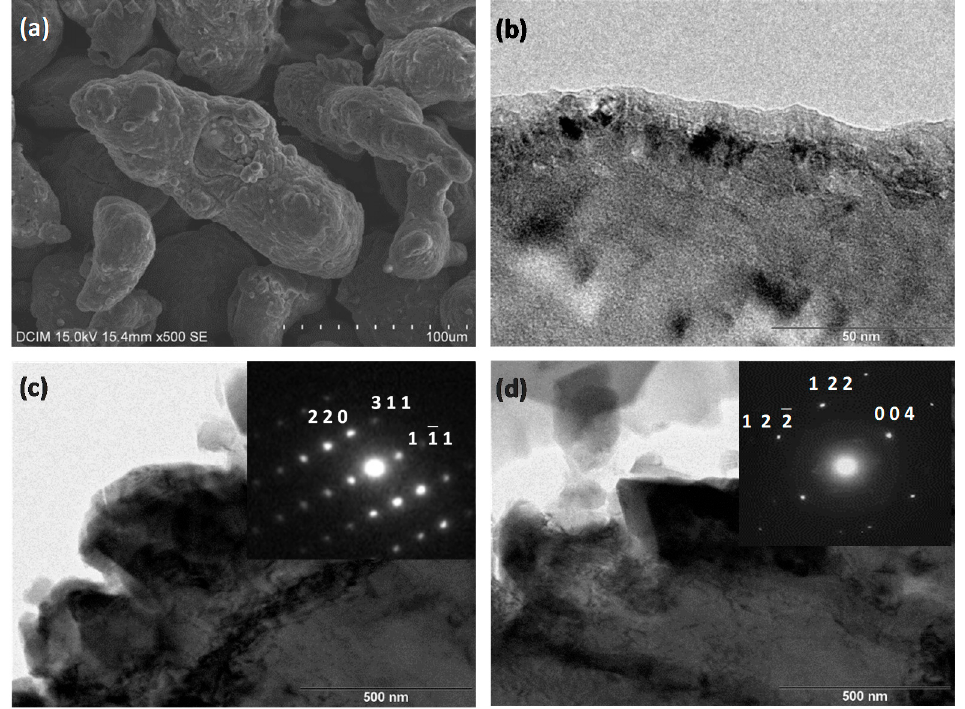
Figure 5. ( a ) AA6061 after the laser treatment; ( b ) Detail of the AA6061/AlN interface. TEM image; ( c ) ED of AA6061/AlN, cubic structure; ( d ) ED of AA6061/AlN, hexagonal structure. ( c ) ED of AA6061 / AlN, cubic structure; ( d ) ED of AA6061 / AlN, hexagonal